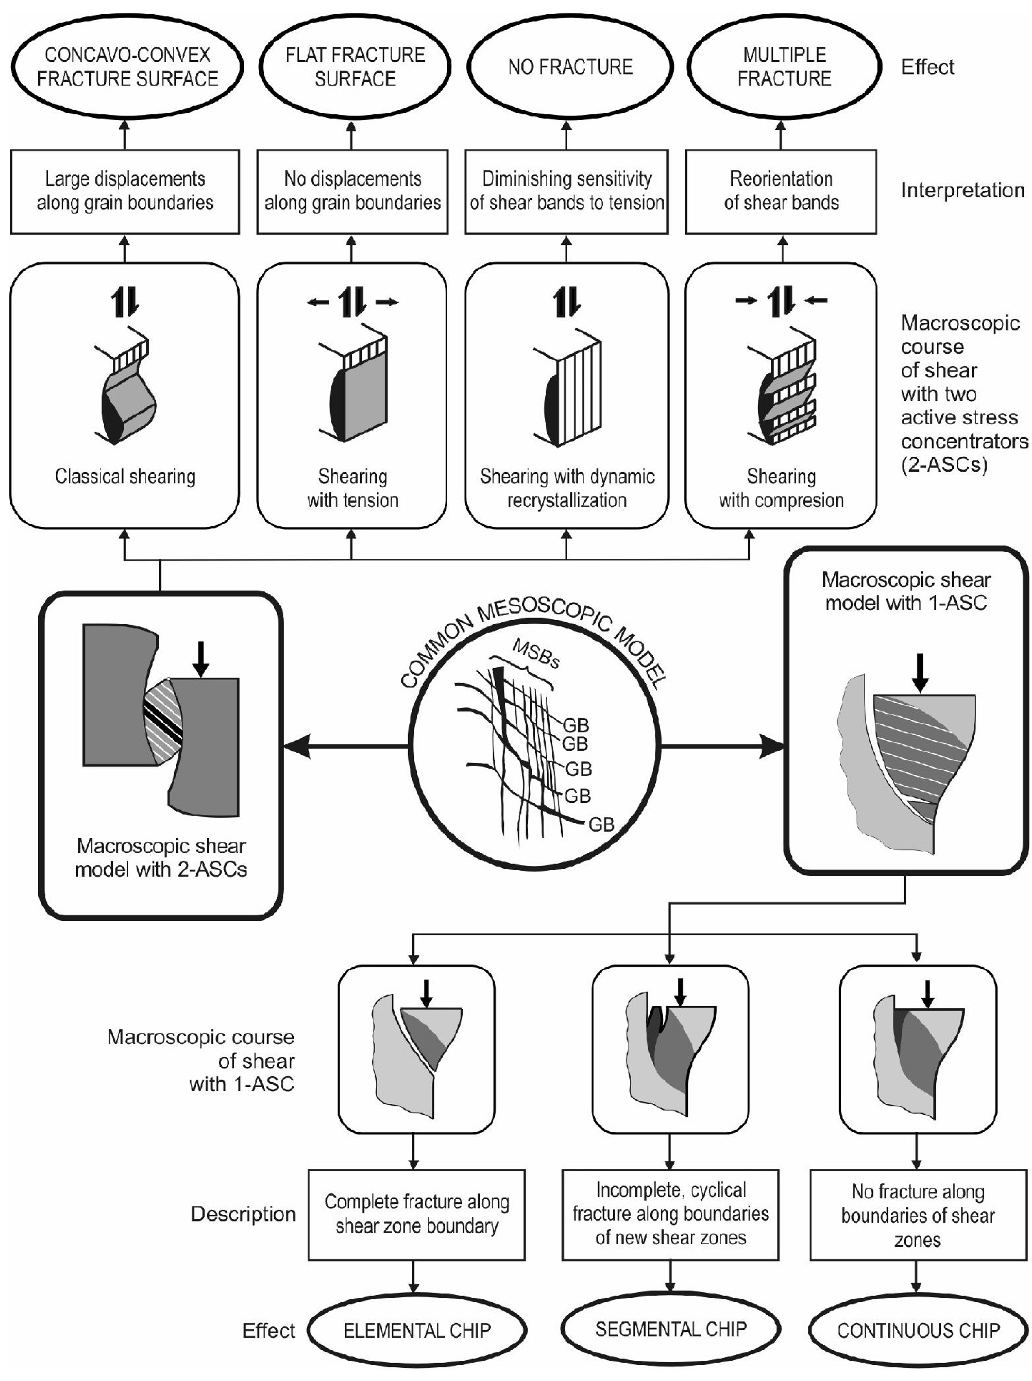
Figure 10. Examples of interpretation possibilities of mesoscopic-macroscopic model of shear mechanism (according to E. S.